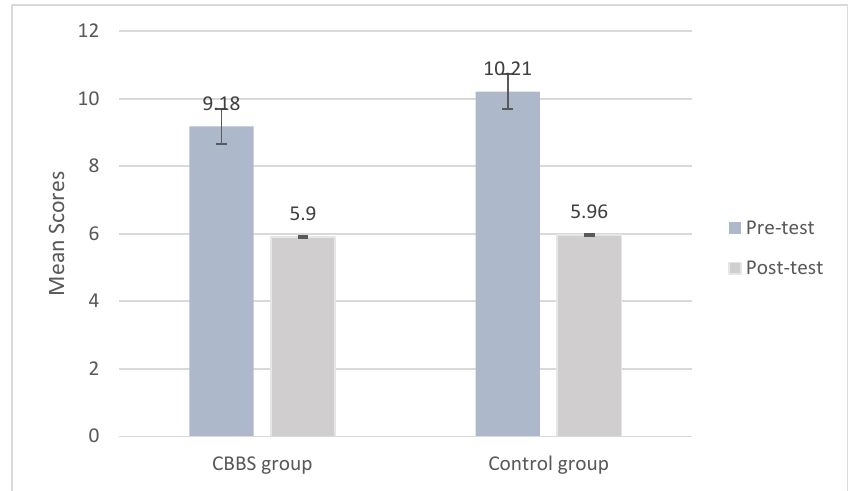
Figure 5. Mean scores of attention accuracy at pre-test and post-test by group. The linear mixed model found no significant main effect of time ( F (1, 785.108) = 1.971, p > 0.05) and group ( F (1, 1169.175) = 0.718, p > 0.05) on the attention span. However, there was a significant interaction effect between time and group ( F (1, 785.108) = 4.836, p < 0.05). The ICC of the attention span is 0.18. The results indicated that the intervention group showed a signifi- cant performance improvement in attention span (i.e., better ability to sustain attention to stimuli) over time compared to the control group, showing a positive intervention effect on attention span (Figure 6).